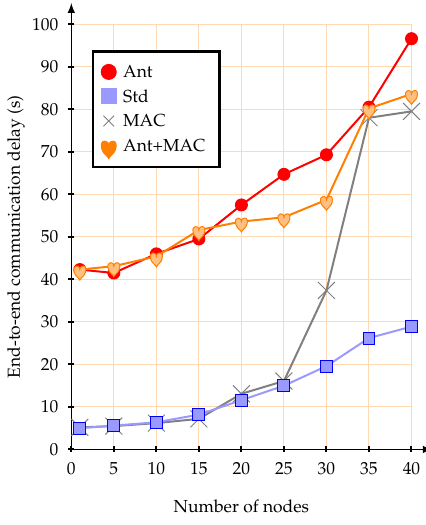
Figure 12. Average end-to-end delay at 5